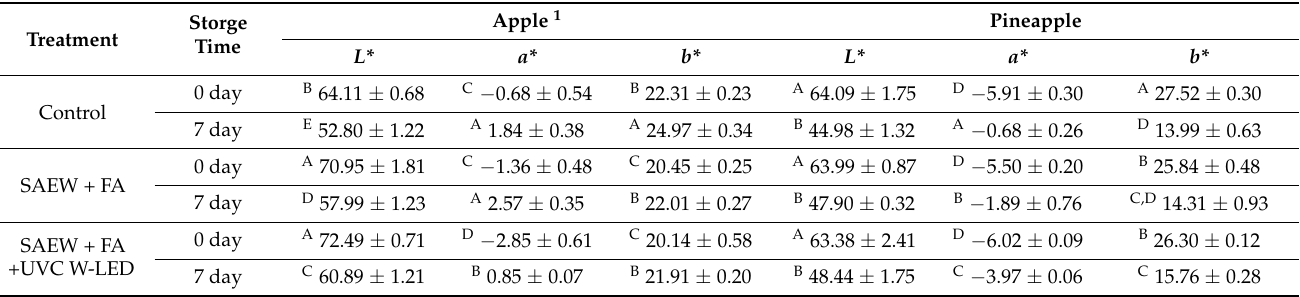
Table 2. Effectiveness of disinfection treatments on color parameters in apple and pineapple after storage for 7 days at 10 ◦ C.